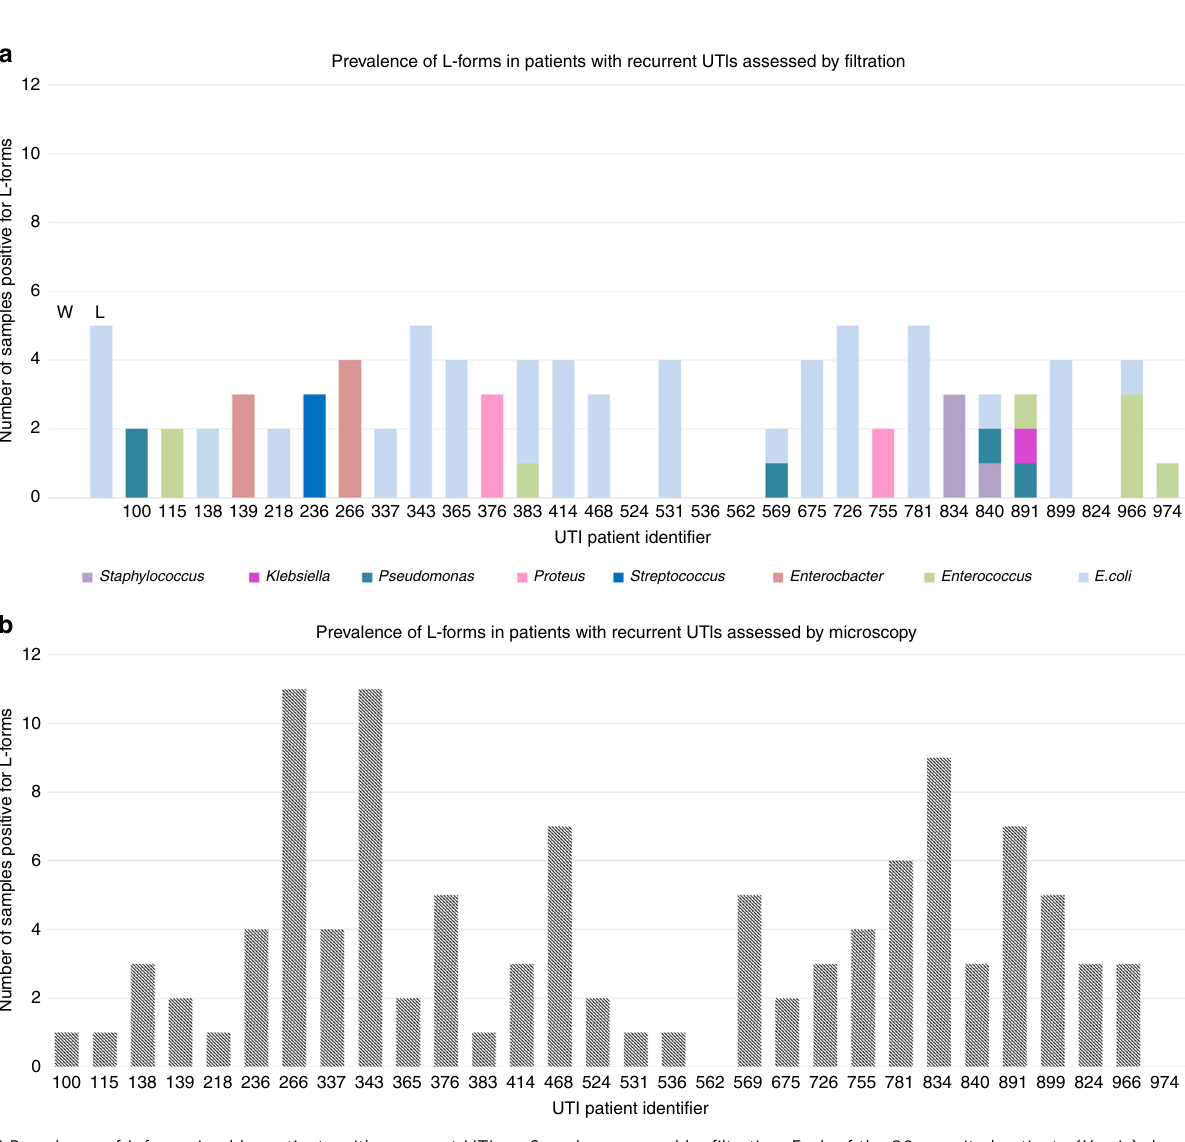
Fig. 1 Prevalence of L-forms in older patients with recurrent UTIs. a Samples assessed by fi ltration. Each of the 30 recruited patients ( X axis) donated a total of 12 samples over the period of 6 months ( Y axis). Samples which contained fi lterable bacteria (some of which were also observed by microscopy), are symbolised by columns marked with solid colour ( a ). Various colours represent species of the fi ltered bacteria identi fi ed by 16S sequencing. W stands for a negative control in which 12 samples of laboratory BW25113 E. coli walled bacteria were passed through the 0.45 µ m cut off fi lter onto osmoprotective media. L stands for a positive control where 12 samples of laboratory E. coli BW25113 L-form bacteria were fi ltered. b Samples assessed by phase contrast microscopy. Samples positive for L-form-like structures when assessed by microscopy are represented by grey, dashed